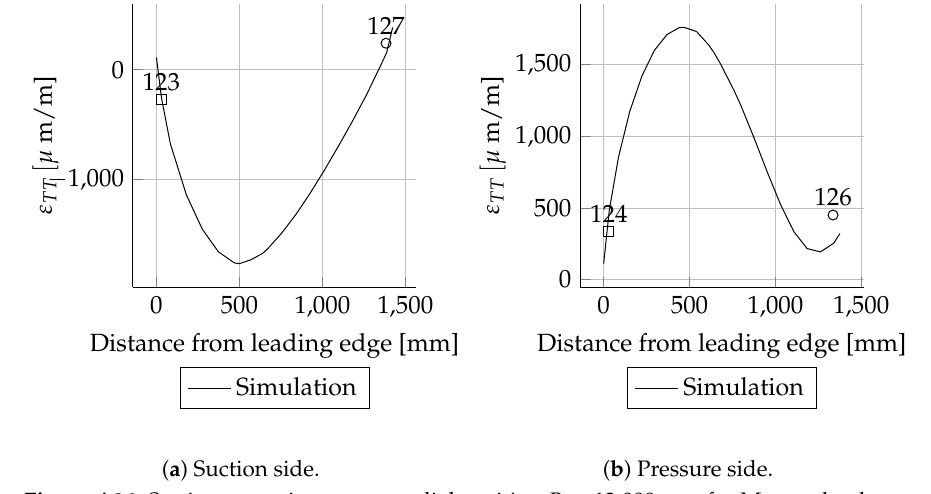
Figure A36. Strain comparison ε LL at radial position R = 13,000 mm for Mymax load case.